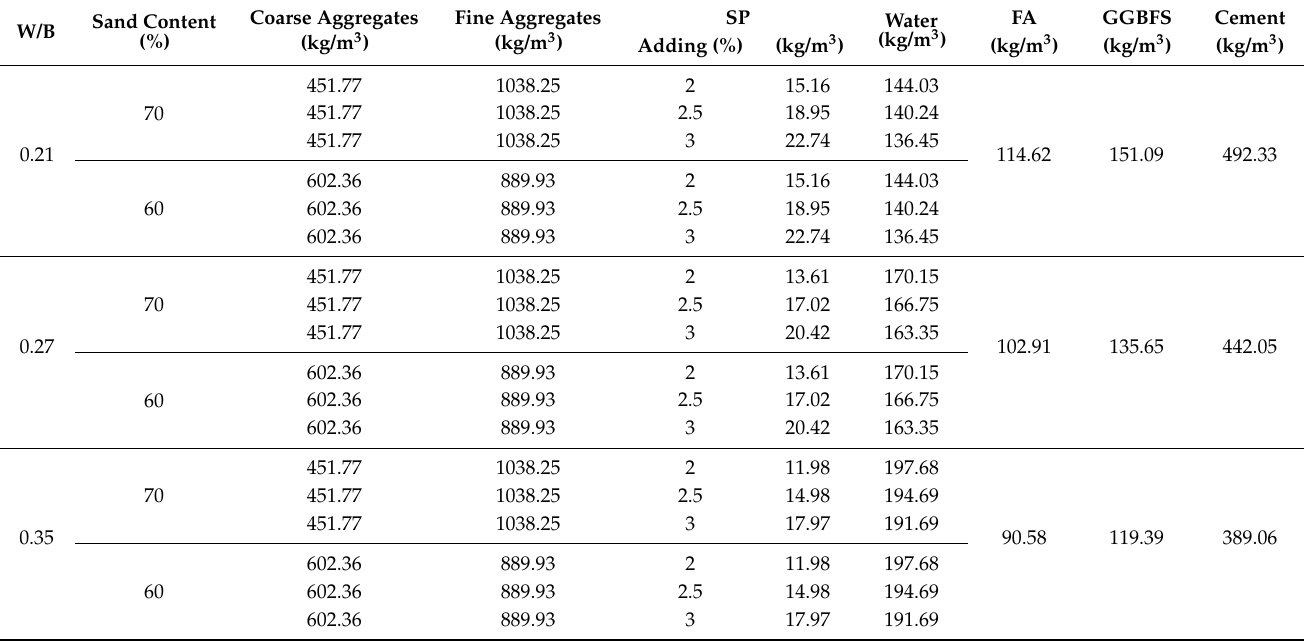
Table 2. Mix proportions of green and ecofriendly grouting